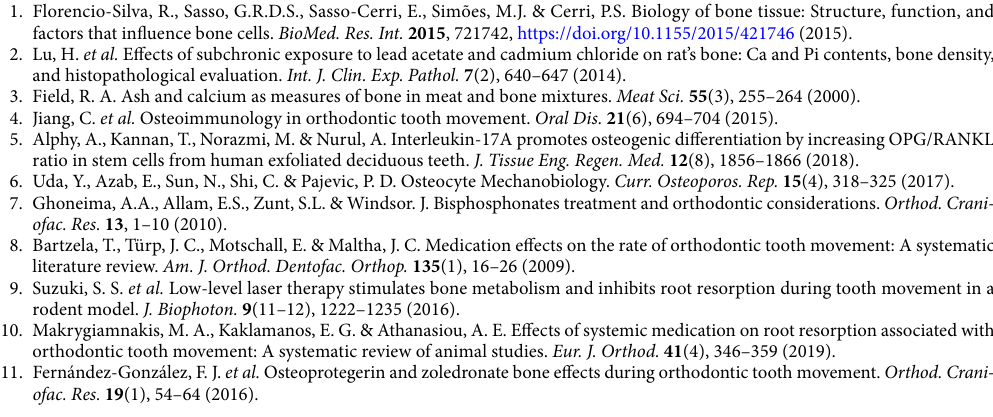
Figure 7. Microarchitecture analysis of trabecular bone on the compression and tension side of the DV root in the Naive, Saline, ZA (0.2) and ZA (1.0) groups. Compression side (A) Analysis of the inorganic portion of the bone volume fraction / total jaw bone volume (*) indicates difference when compared to the naive group (#) indicates difference when compared to the saline group. (ANOVA p < 0.001, Levene p = 0.040, Games- Howell pos-hoc test). (B) Measures of density of number of trabeculae (Tb.N), (C) thickness (Tb.Th) and (D) separation between trabeculae (Tb.Sp), (*) indicates difference when compared to the naive group (#) indicates difference when compared to the saline group. (ANOVA p = 0.001, Levene p = 0.250, Tukey post-hoc test). Tension side (E) BV/TV fraction density measurements, (F) number of trabeculae (Tb.N), (G) thickness (Tb. Th) and (H) separation between the trabeculae